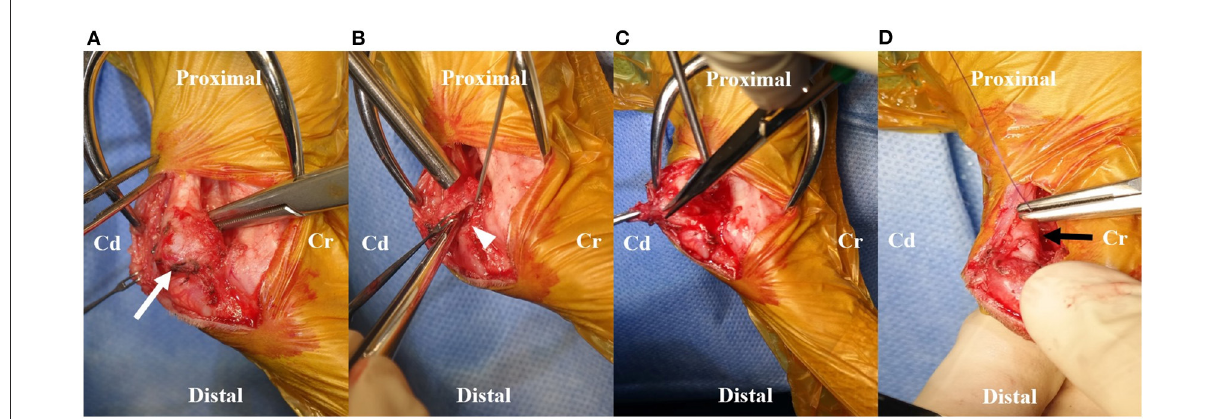
FIGURE4 Intraoperative images. (A) Prominently enlarged gastrocnemius calcaneal bursa (white arrow) was identified intraoperatively. (B) The serous fluid was released from the incised opening (white arrowhead) on the bursa using a No.11 blade. The opening of the bursa was extended by Castroviejo scissors. (C) The dissection using tenotomy scissors was performed until the normal Achilles tendon was isolated from the bursa. The redundant bursa was removed. (D) The medial retinaculum was sutured to the edge of the tendon using monofilament, absorbable suture material. Note the appearance of normal Achilles tendon after removal of gastrocnemius calcaneal bursa with shrinkage of the swollen lesion (black arrow). Cd, Caudal; Cr, Cranial.